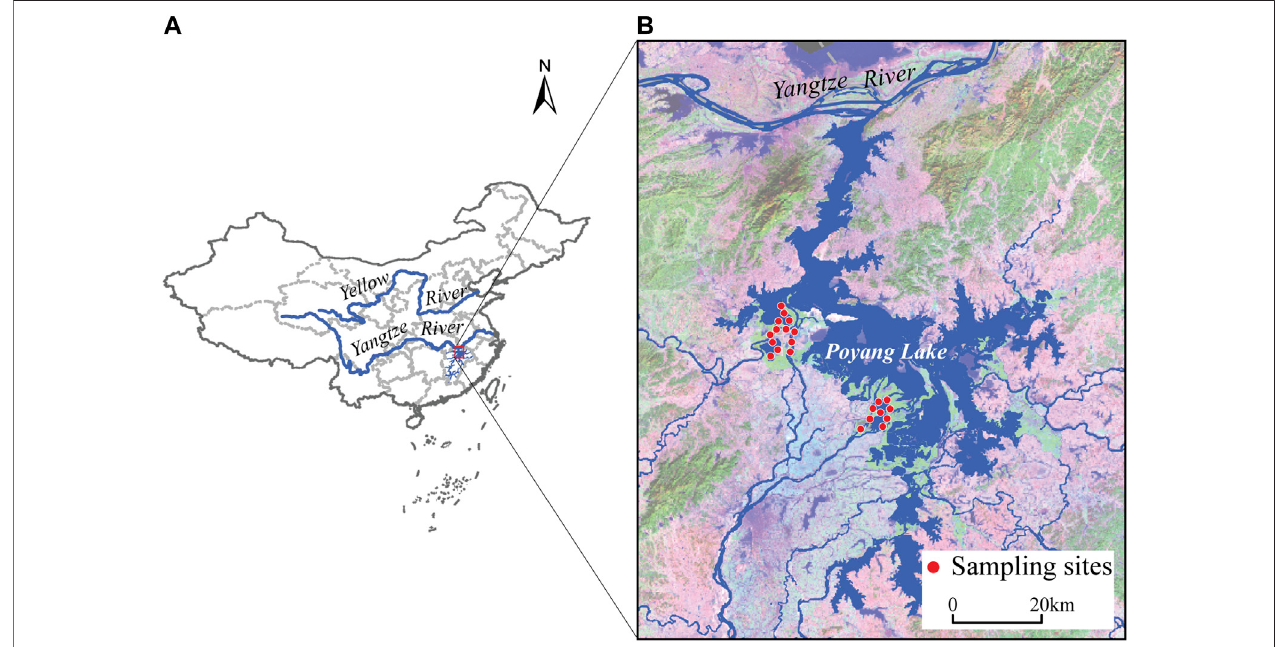
FIGURE 1 | Location of Poyang Lake in the Yangtze River Basin, China (A) , and locations of sampling sites (B) .